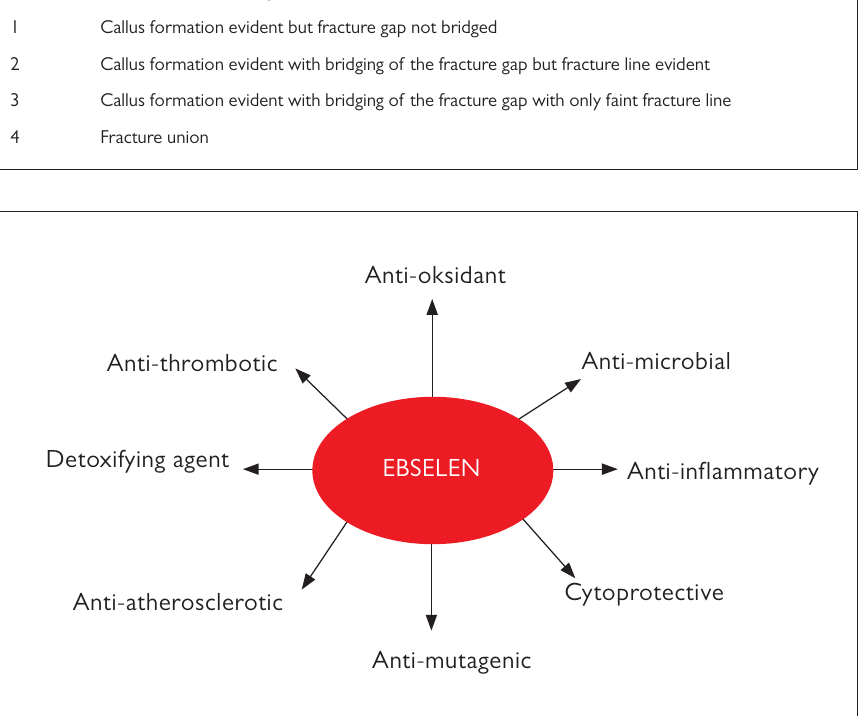
Table 1. The 5-point radiographic scoring system [25]